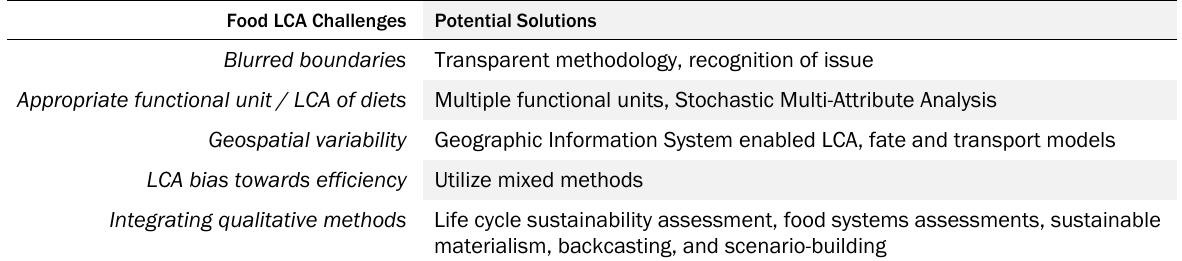
Table 1. Several Potential Solutions to Deal with Challenges Facing Food LCA Food LCA